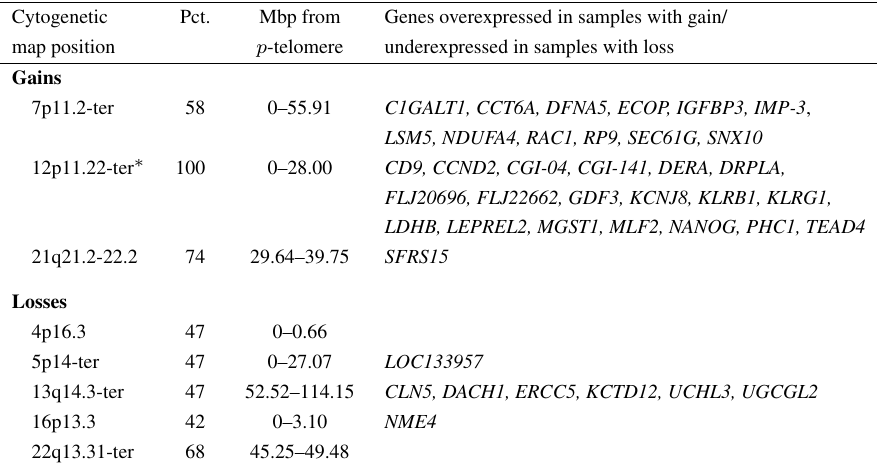
Smallest regions of overlapping gains and losses. These genomic regions were identified by showing DNA copy number changes in more than 40 percent of the samples and being limited by break points in at least three tumors at each side. For each region, genes with DNA copy number associated expression are listed Cytogenetic Pct. Mbp from Genes overexpressed in samples with gain/ p -telomere underexpressed in samples with